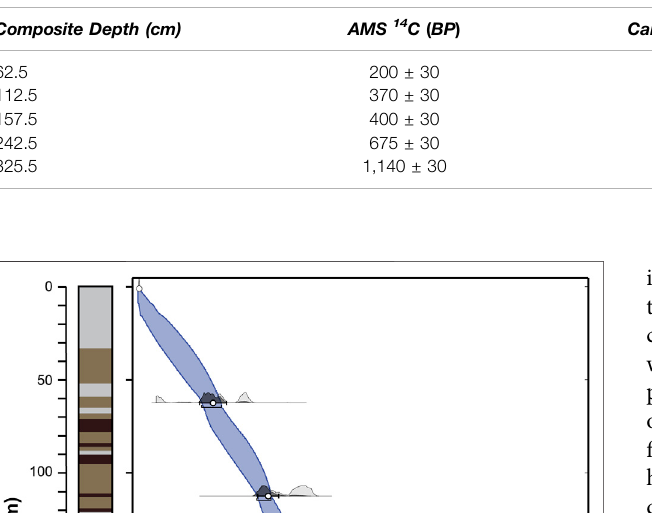
Frontiers in Earth Science |